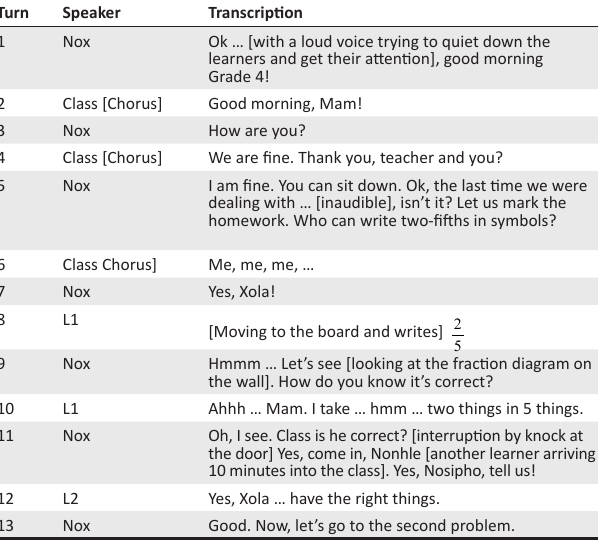
TABLE 1: Routines in Nox’s